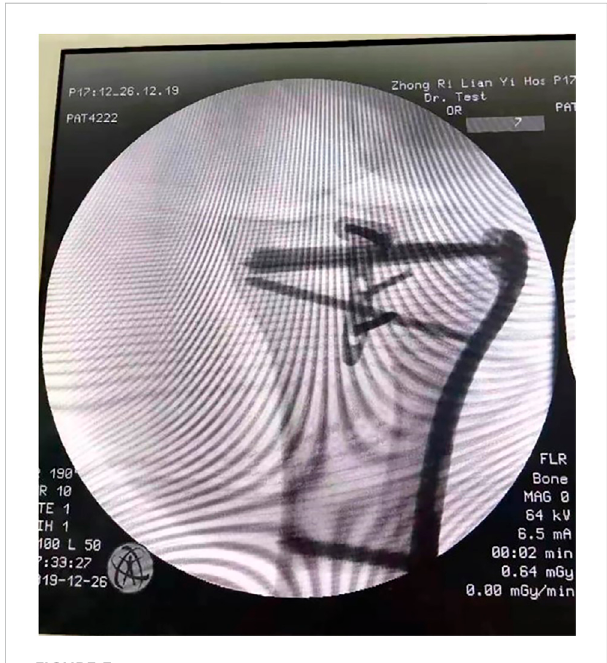
Intraoperative C-arm fl uoroscopy to con fi rm fracture reduction.